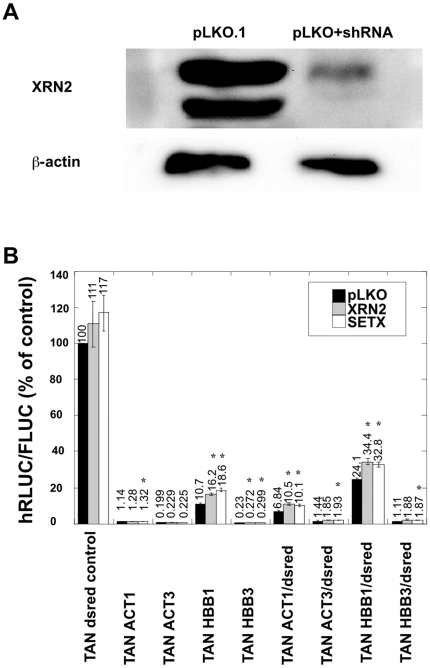
Xrn2 and Senataxin knockdowns provide limited release from transcription termination.
A, Western blot analysis of Xrn2 knockdown in whole cell extracts. TAN dsred control cell line was grown as indicated in the methods and transfected with a plasmid expressing an shRNA targeting Xrn2. Samples were run on duplicate gels in parallel, blotted and then probed for Xrn2 expression. Anti-Xrn2 antibody (Bethyl Laboratories) produces a doublet, shown here. The lower band disappears with shRNA targeting Xrn2, and the upper band shows reduced density. Anti-human β-actin antibody serves as a control. The analysis was performed three times, with a representative blot shown. B, Xrn2 and senataxin knockdowns each provide little release from transcription termination. Cell lines were grown as detailed in the methods. The y-axis values are hRLUC/FLUC expression ratios normalized to a positive cell lysate run in each plate. Error bars indicate the S.E.M. for a sample number of three. Significant differences (p<0.05) from the corresponding vector (pLKO) treated samples are indicated by asterisks.